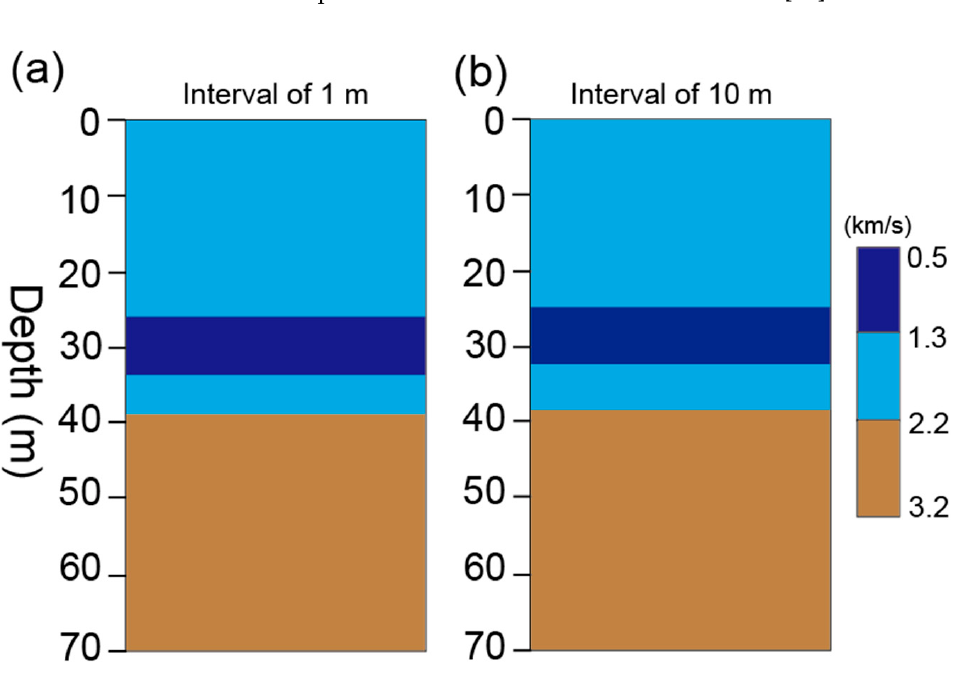
Figure 7. The thickness of the KQGR glacier calculated by glacier surface motion and slope. 4. Discussion We observed many different types of icequakes including shallow, deep and hybrid events. Shallow icequakes are associated with ice surface crevasse opening or propaga-